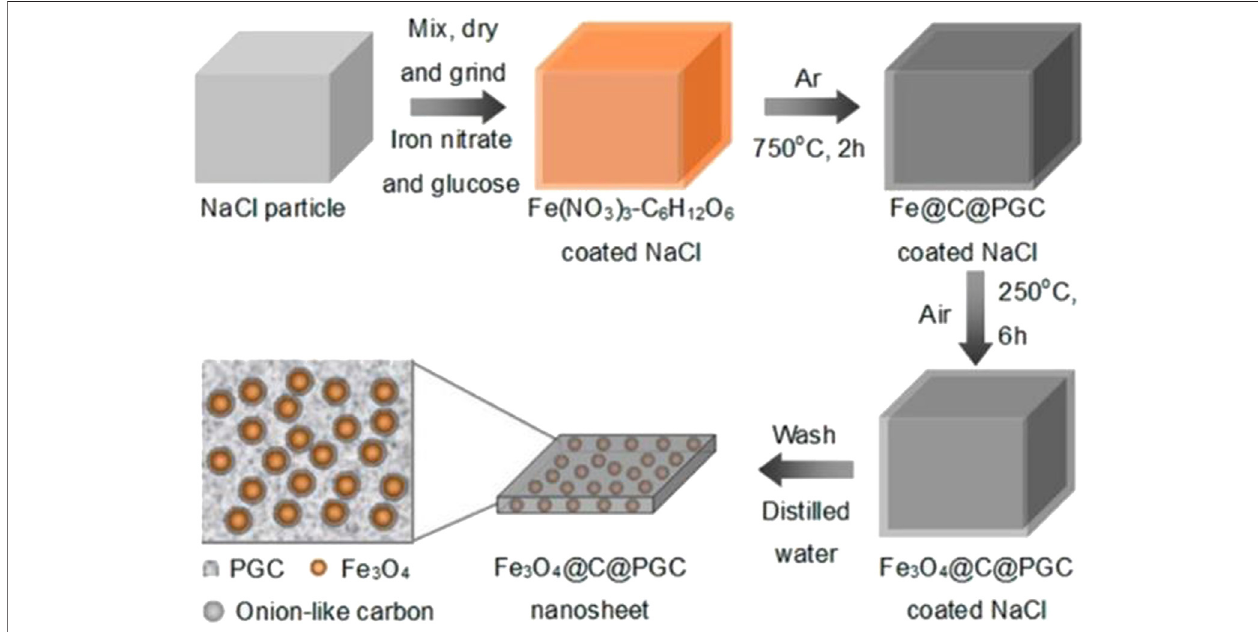
FIGURE 2 | Schematic illustration of the in situ technique to fabricate 2D Fe 3 O 4 @C@PGC nanosheets by using the surface of NaCl particles as the template. Reprinted with permission from (He et al., 2013). Copyright (2021) American Chemical Society.